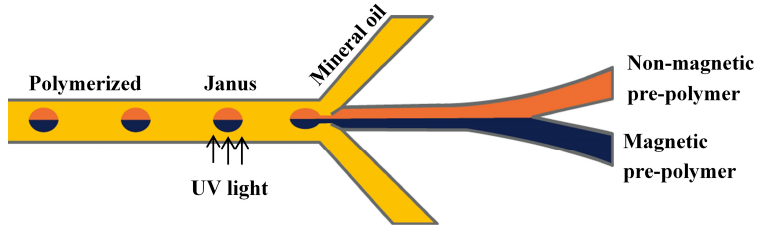
Figure 27. A planar microfluidic device for the fabrication of Janus particles composed of a Y-junction, a cross junction and ultraviolet (UV) lamp. Pre-polymer streams are injected from two inlets and the drops are surrounded by mineral oil at the cross junction. After UV exposure, Janus particles with magnetic anisotropy are formed [157].